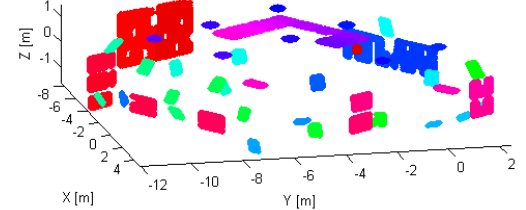
Figure 15: Sample of planar features extracted from the HDS6100 point cloud for use in the plane-based